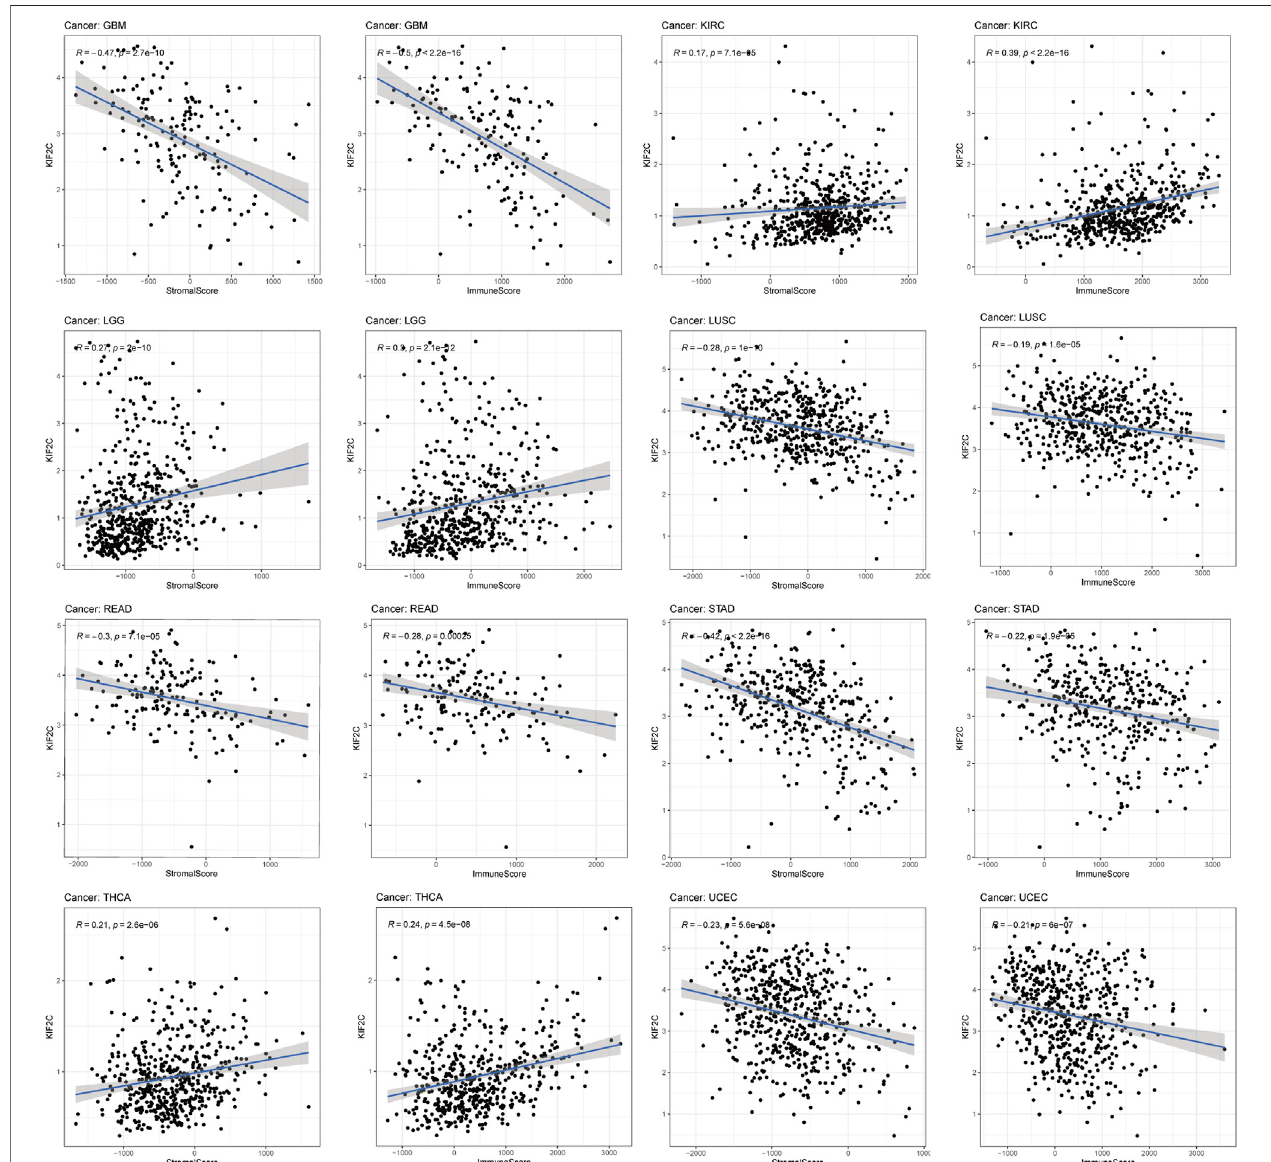
FIGURE 5 | The correlations between KIF2C expression and the stromal and immune cell ’ s level of tumor microenvironments in pan-cancer.